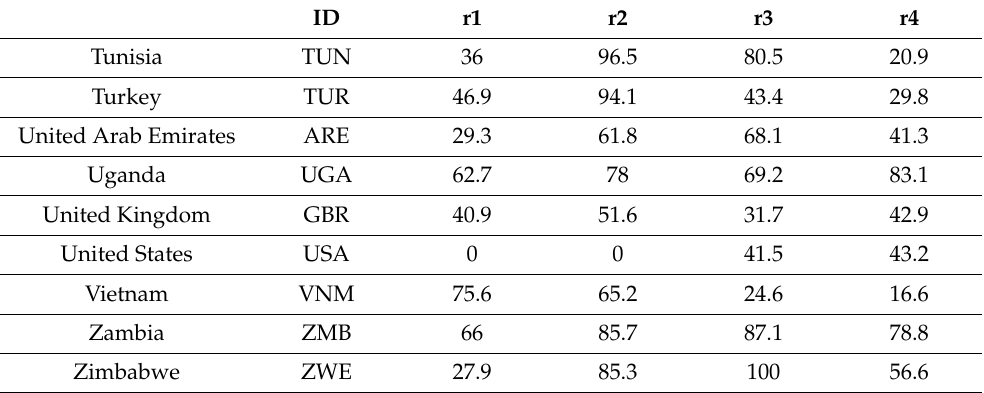
Based on the above data (Table 11), a Hasse diagram was constructed (Figure 2).